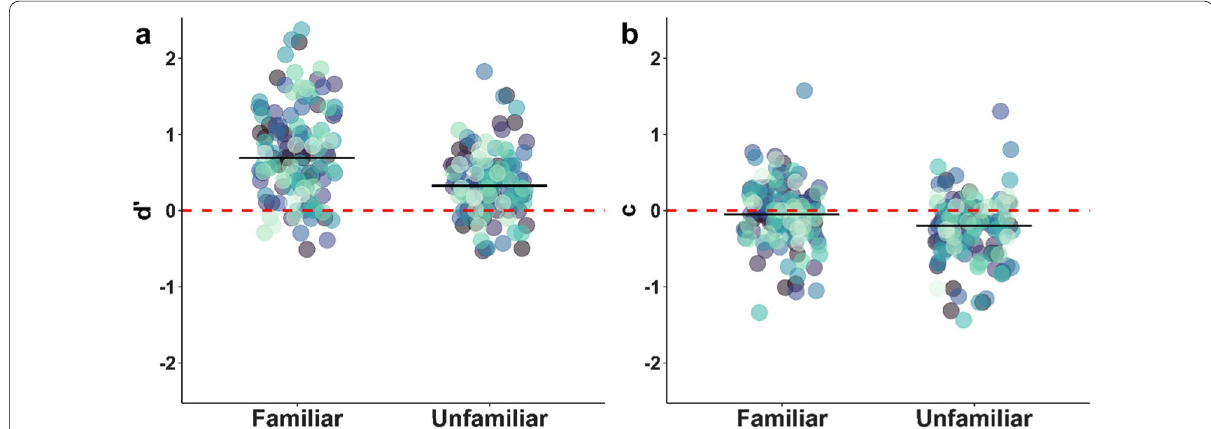
Fig. 4 Sensitivity ( d ′ ) and response bias ( c ) for mask memory, depending on the familiarity of faces. Note. Black horizontal lines indicate median values. Same colors indicate data points from the same participant. Each data point shows the sensitivity ( d ′ ; panel a ) or response bias ( c ; panel b ) of a single participant indicating whether a given face wore a mask in the study phase, separately for familiar and unfamiliar faces. a Advantage for remembering whether a familiar face wore a mask. Higher values of d ′ indicate better performance. A value of zero indicates ‘guessing.’ b Stronger liberal bias for indicating unfamiliar faces wore a mask. Values greater than zero indicate a conservative bias (tendency to answer ‘no’), and values lower than zero indicate a liberal bias (tendency to answer